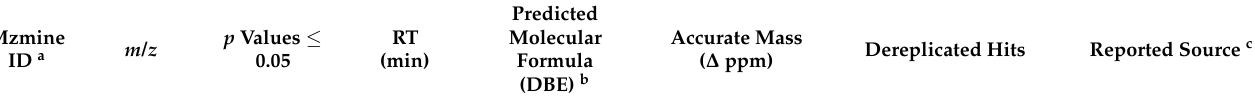
Table 2. Discriminating metabolites between Malaysian and New Zealand (NZ) honey samples extracted from the loading S-plots at p < 0.05. The list was arranged according to their p values as determined by